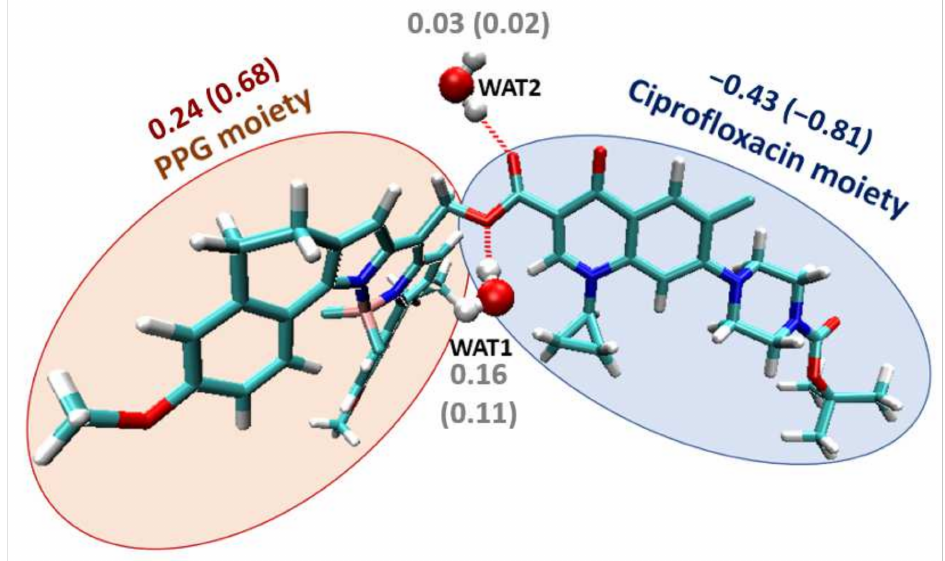
Figure 5. Moieties considered for charge analysis (depicting as an example the structure of 5 ), showing the explicit water molecules and their hydrogen-bond interactions (dotted red lines). The charge of each moiety computed at the T 1 minimum (T 1 transition state) are also